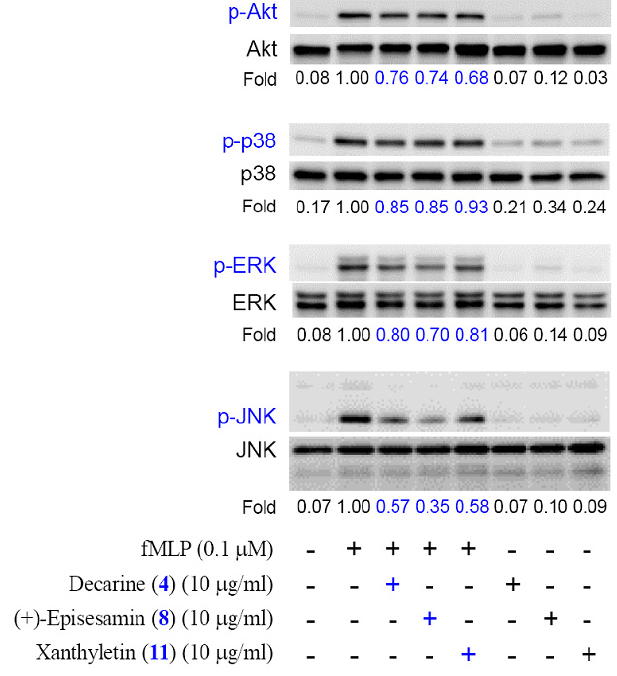
Figure 5. Compounds 4 , 8 , and 11 inhibit the phosphorylation of MAPKs and Akt in fMLP-activated neutrophils. Cells were treated with 4 , 8 , and 10 (10 μ g/mL) for 5 min, and then stimulated with fMLP for 30 s. Phosphorylation of MAPKs and Akt was analyzed by immunoblotting. Densitometric analysis of all samples was normalized to the corresponding total